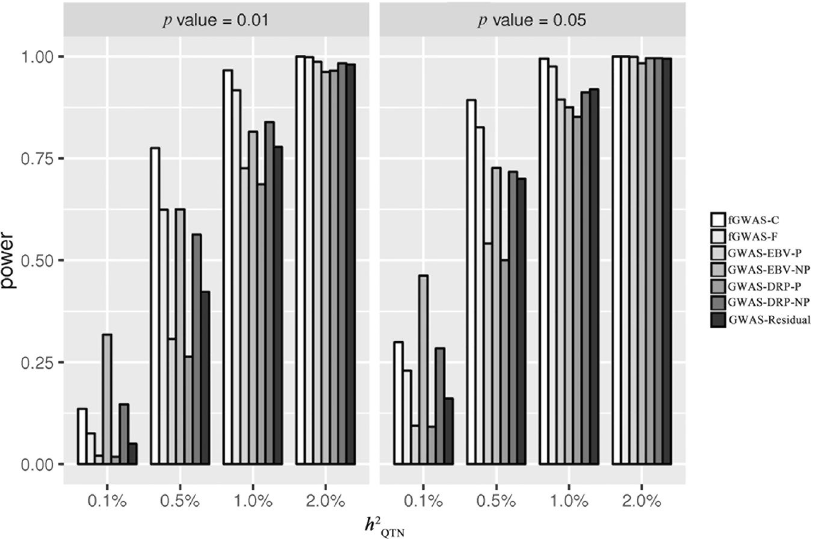
Figure 2. The powers of different GWAS models with alternative QTN heritabilities at tabulated thresholds of p = 0.01 and p = 0.05 for the simulation